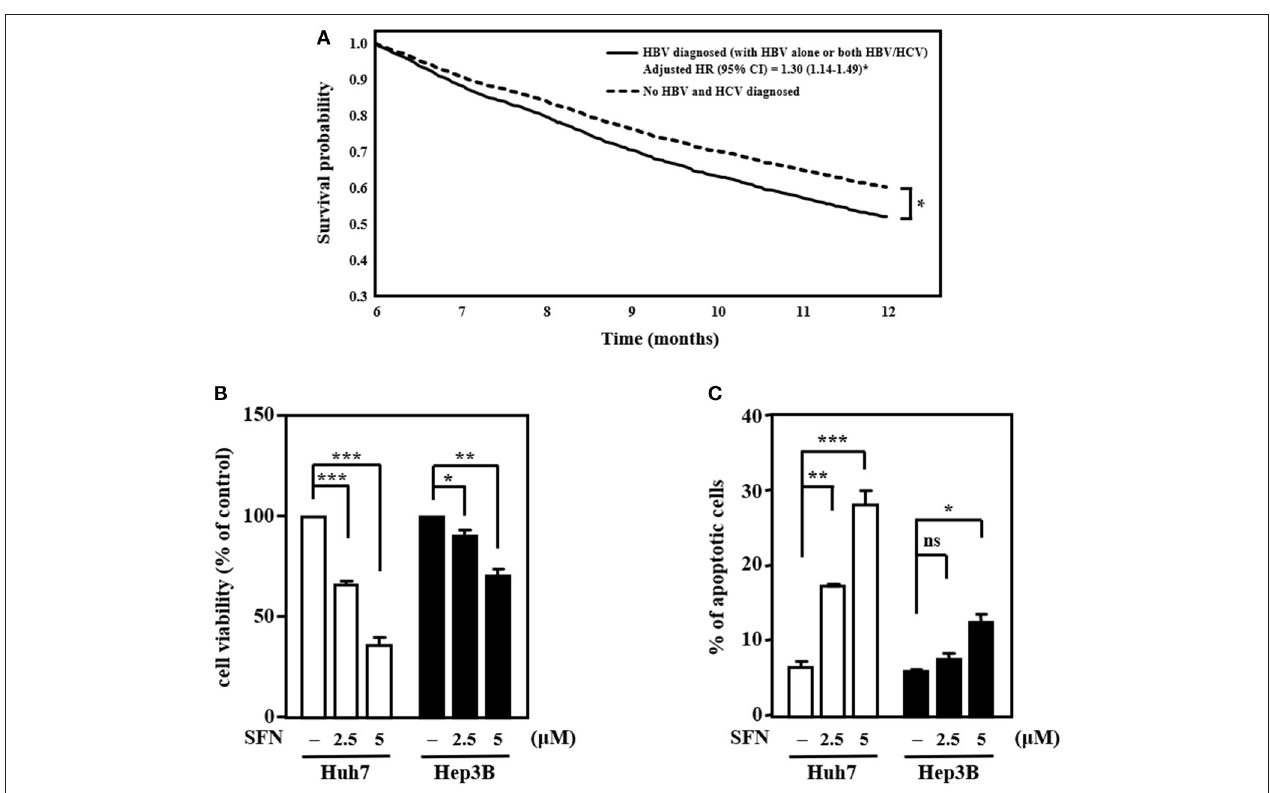
FIGURE 1 | HCC cells with HBV are more resistant than those without HBV to the anti-cancer effects of sorafenib. (A) The survival curves for more than 6 months follow-up period. (B) Huh7 and Hep3B cells were treated with sorafenib (SFN) at the indicated concentrations for 48h. The cell viability of the experimental cells was measured by MTT assays after 48h of sorafenib treatment at the indicated concentrations. (C) Huh7 and Hep3B cells were treated with sorafenib at the indicated concentrations for 48h. Experimental cells were collected after 48h of sorafenib treatment at the indicated concentrations, stained with Annexin-V/PI, and analyzed by flow cytometry. The data are shown as the mean ± SD. * P < 0.05; ** P < 0.01; *** P < 0.001 by Student’s t